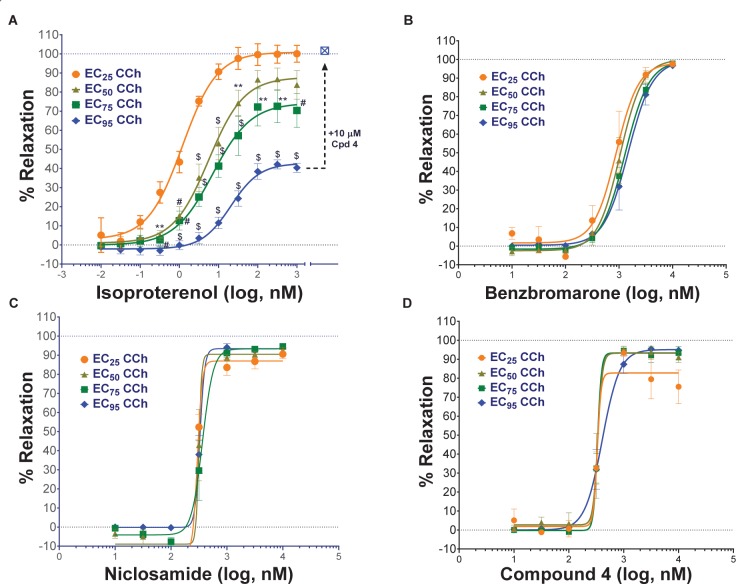
TMEM16A antagonists fully relax airways in the presence of low and high concentrations of contractants, while the β-agonist isoproterenol showed only limited efficacy on maximally contracted airways. Mouse tracheal rings were pre-contracted with EC25 – EC95 concentrations of carbachol (CCh) and then treated with the β-agonist isoproterenol (A), or the TMEM16A antagonists benzbromarone (B), niclosamide (C) or Compound 4 (D) to measure bronchodilation using a DMT wire myograph (n = 3–5 rings per condition). A maximally contracted airway ring using an EC95 level of carbachol that showed only partial bronchodilation after the highest isoproterenol dose, was fully relaxed by add-on of the TMEM16A antagonist Cpd 4 (% relaxation shifts from 37.7% → 101.7% at EC95); see arrow to open blue square, cross-hatched (A). Mean ± SEM. ∗P
< 0.05, ∗∗P
< 0.01, #P
< 0.001, $P
< 0.0001, two-way ANOVA with Dunnett’ s multiple comparison test for differences from the EC25 of CCh in each group. Only the isoproterenol group showed a significant difference in the dose-response relationship depending on the level of CCh pre-contraction, while no significant effects were observed for the benzbromarone, niclosamide or Cpd 4 groups.